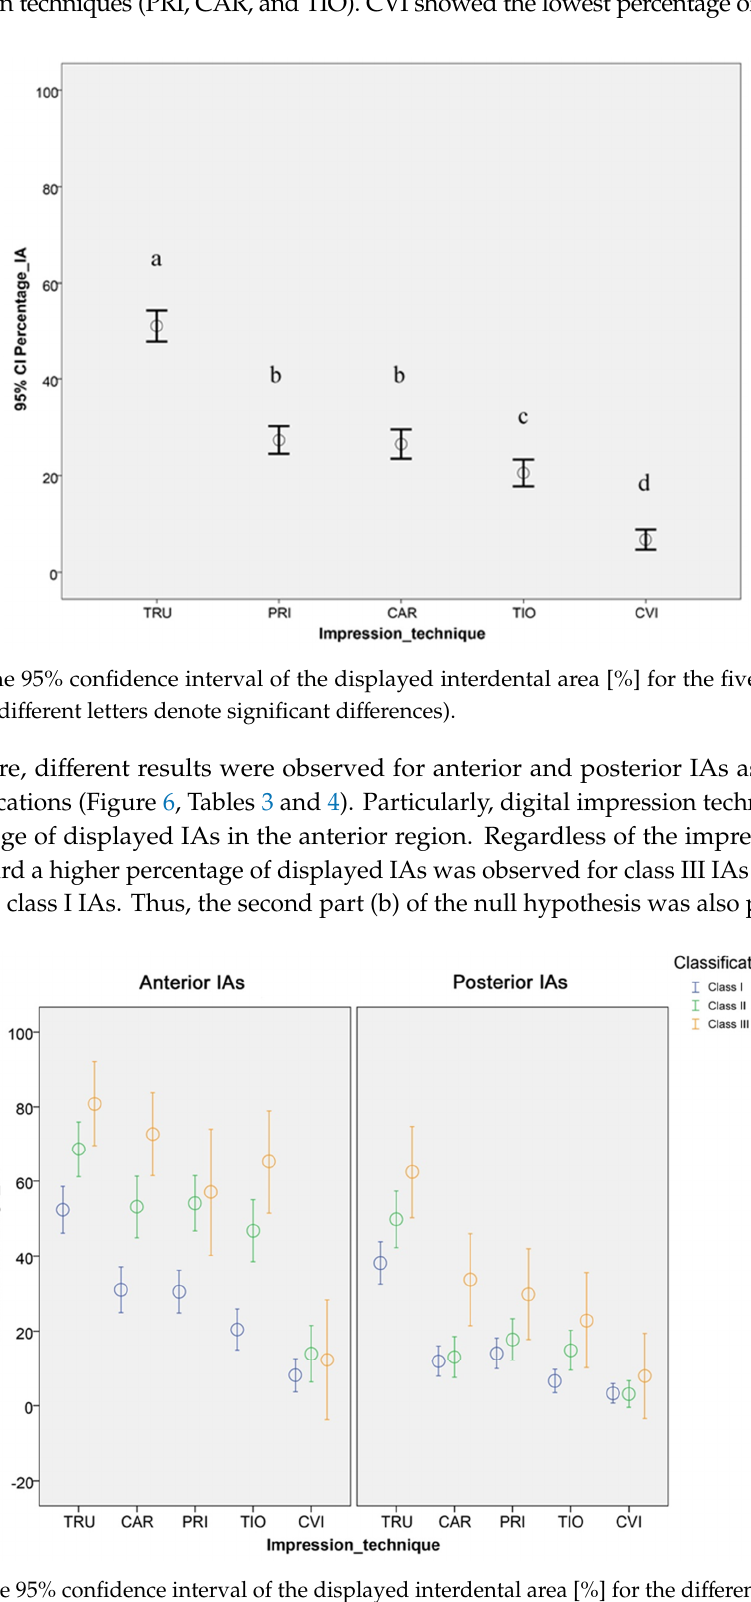
Figure 6. The 95% confidence interval of the displayed interdental area [%] for the different impression techniques and classification by Nordland and Tarnow [35] shown separately for anterior and posterior IAs. Table 3. Descriptive statistics and results of the Median test corrected by the Bonferroni method for anterior teeth.